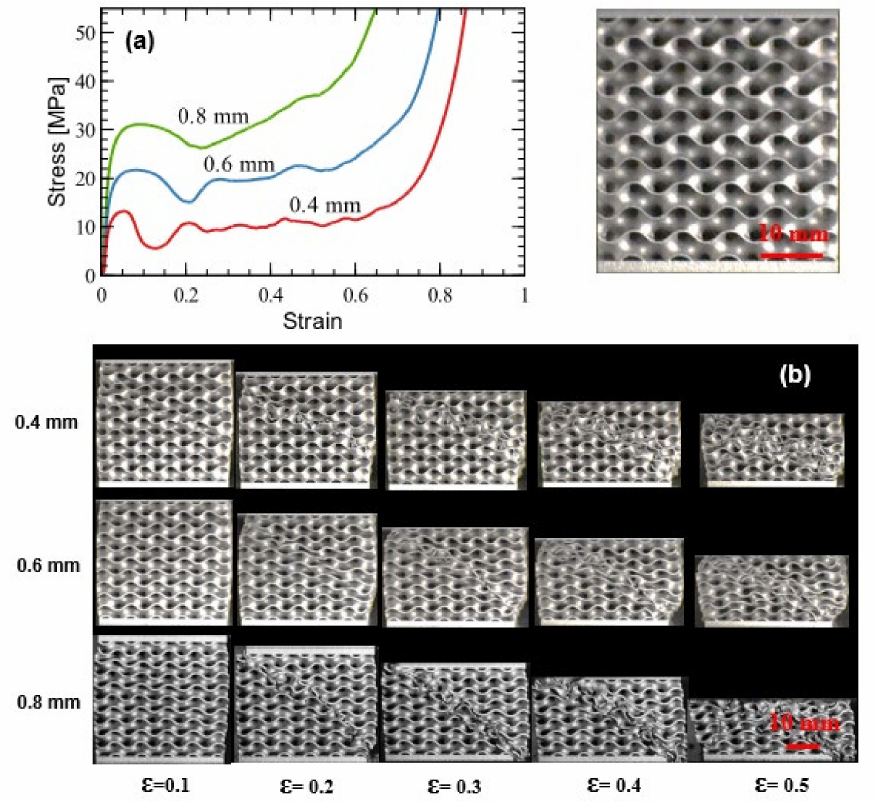
Figure 16. ( a ) Stress–strain curves for gyroid TPMS structure under compression with 0.4, 0.6 and 0.8 mm wall thicknesses, and ( b ) gyroid TPMS deformation sequence for each of the three wall thickness specimens at increasing strain.